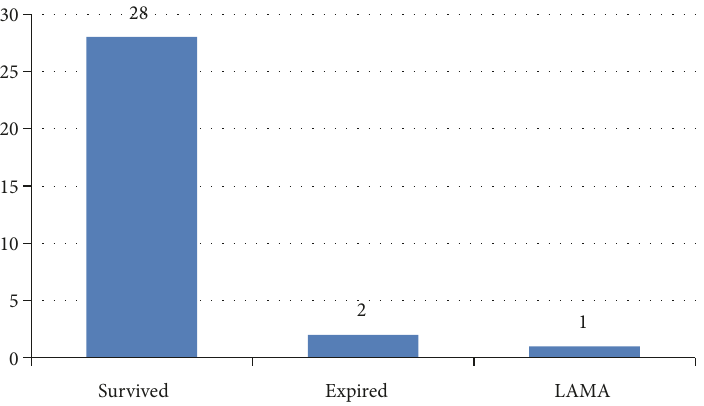
Figure 2: Outcome of patients with Guillain-Barre syndrome (n: 31). Abbreviation . LAMA: leave against medical advice.